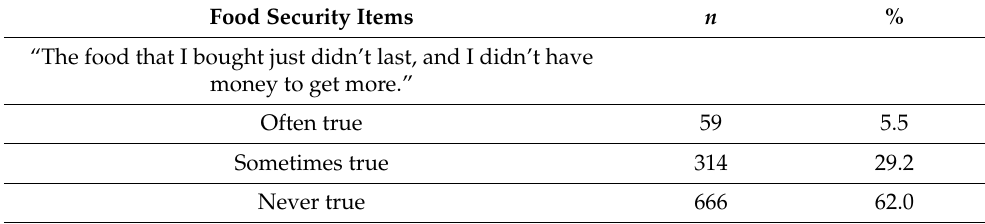
Table 1. Student responses to the USDA Food Security Short Form. Food Security